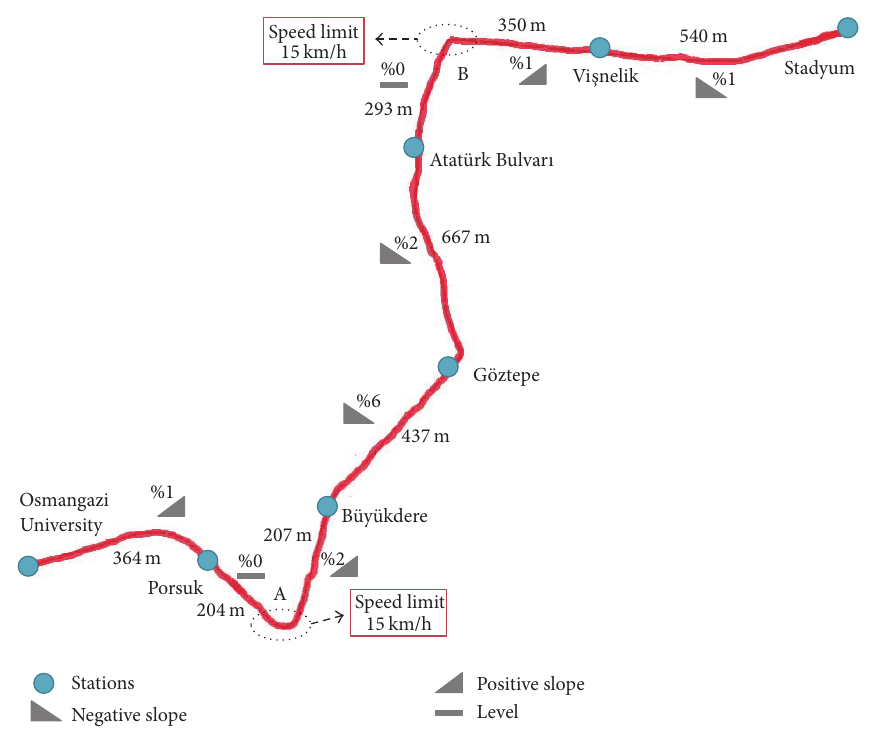
Figure 4: A part of Eskisehir light rail network subjected to test.